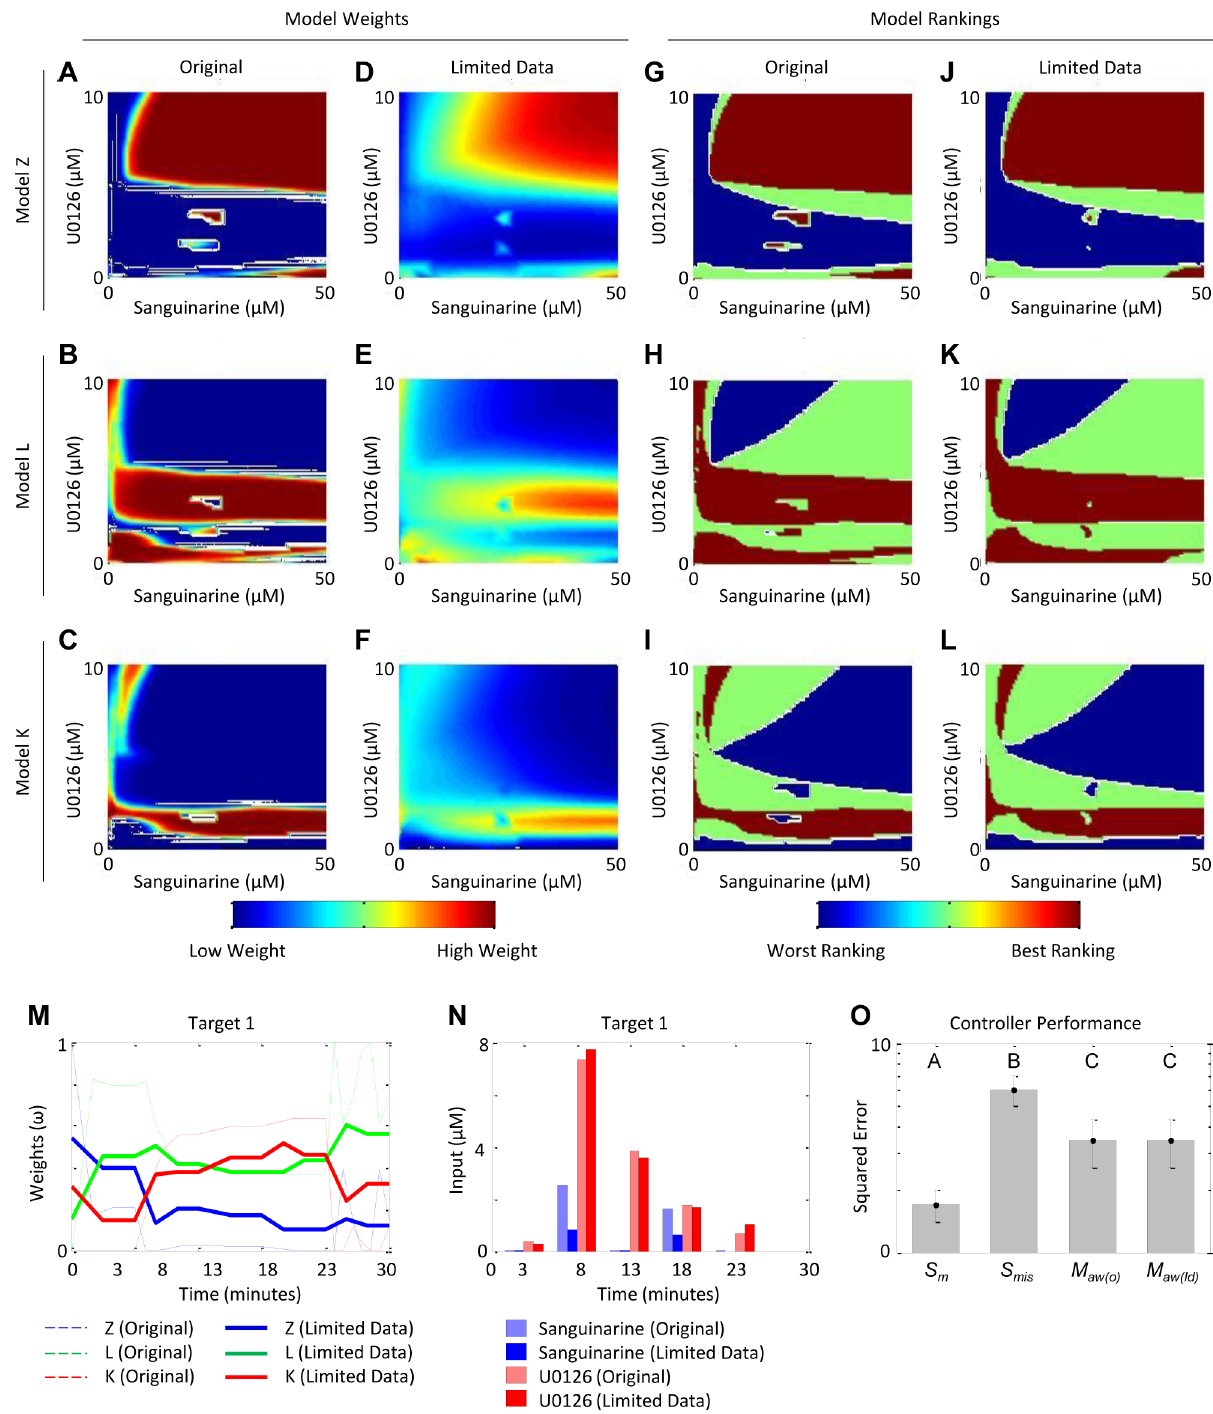
Figure 7. Analysis of uncertainty in the model weight maps and resulting predicted control strategies and performance. Model weights over the input space for ( A – C ) the original case study (full dataset) and ( D – F ) the case study with the limited dataset. Model rankings over the input space for ( G – I ) the original case study (full dataset) and ( J – L ) the case study with the limited dataset. ( M ) Adaptive weights and ( N ) corresponding control input regimen for the exemplar experiment characterized by the target trajectory defined by the pair ( t off =8, p ss =0). ( O ) Controller performances as measured by squared error between target trajectories and plant dynamics controlled by single-model controllers that are matched ( S m , n=30) and mismatched ( S mis , n=60), and adaptively-weighted multiple-model controllers with the original ‘‘digital’’ weight maps ( M aw(o) , n=30) and smoother weight maps from the limited dataset ( M aw(ld) , n=30). Data shown are mean 6 standard error. Group letters denote statistically significant differences between groups (p , 0.05) as calculated by one-way ANOVA with Tukey multiple comparisons test (SigmaStat v3.5, Systat Software, Inc).